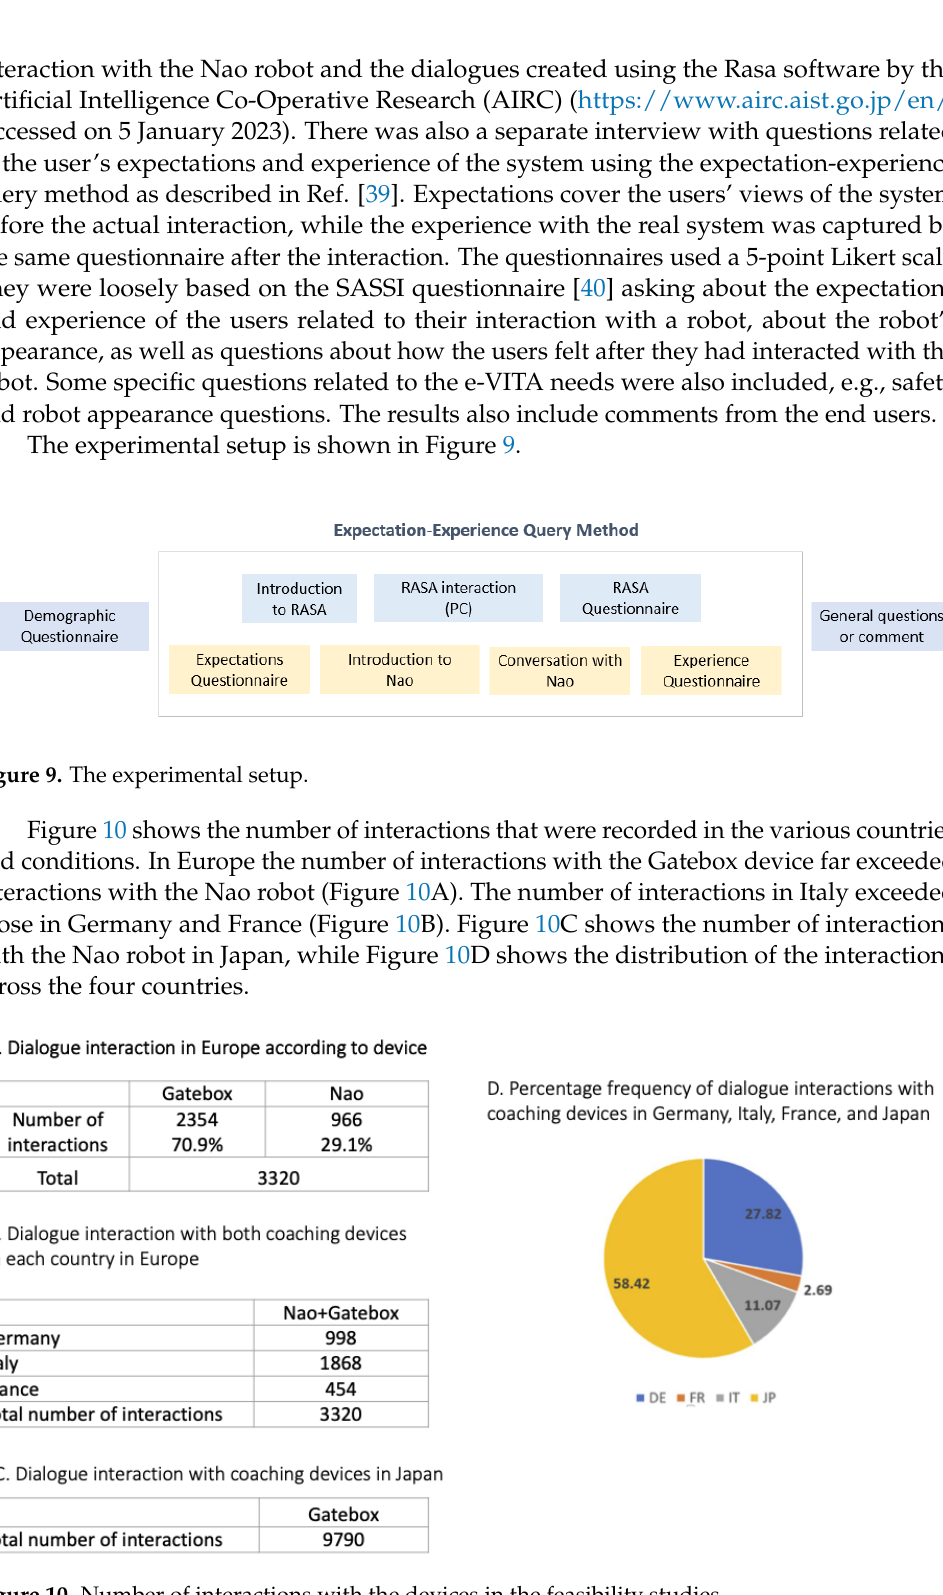
Figure 10. Number of interactions with the devices in the feasibility